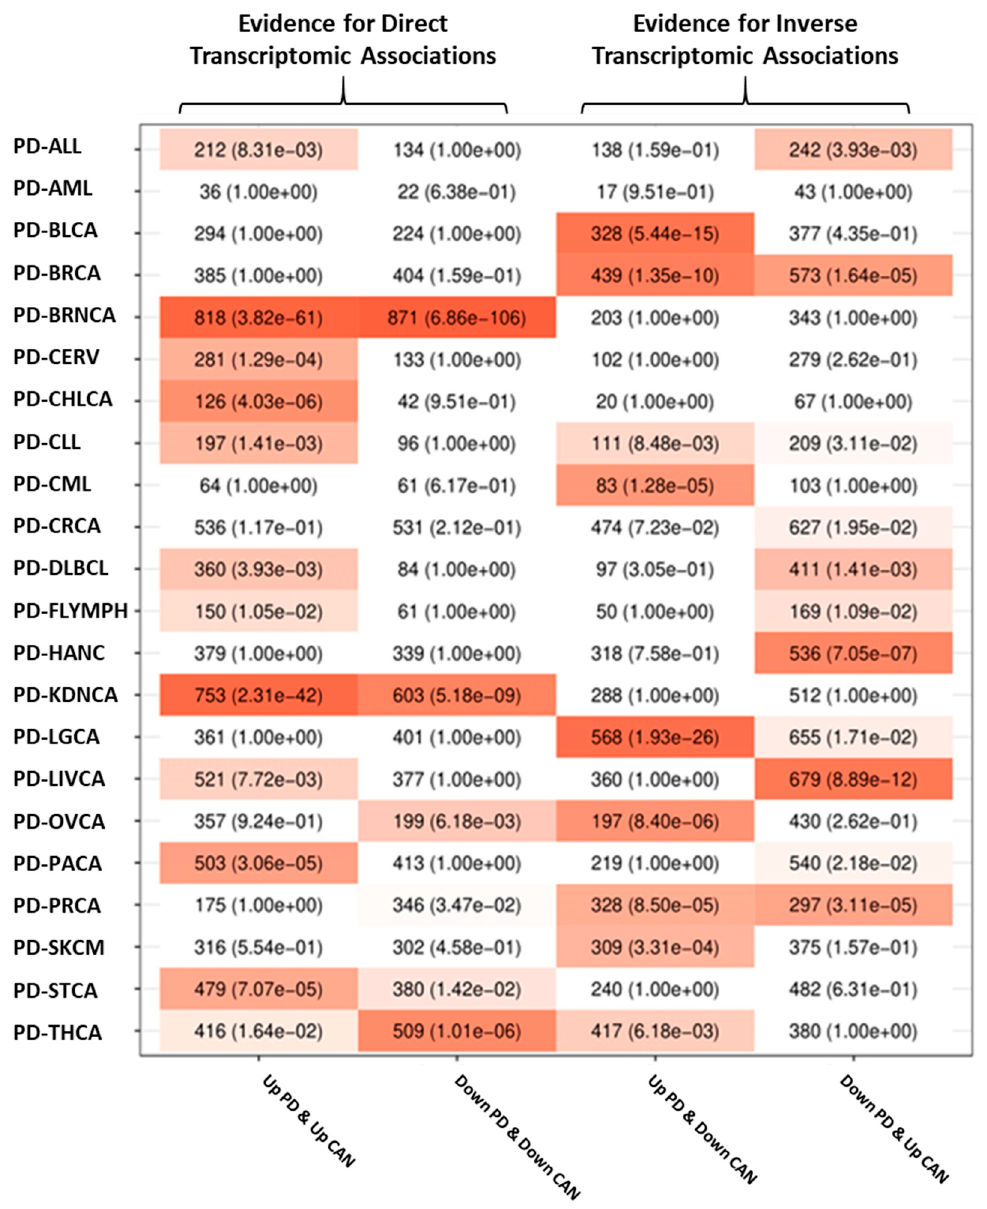
Figure 3. PD and cancer intersection analysis results. Each column shows the number of genes at the four possible intersections formed by up- and downregulated genes in each PD and cancer pair, as well as the FDR-adjusted p -values of Fisher’s exact tests. Column 1 shows genes upregulated in both conditions, column 2 shows genes downregulated in both conditions, column 3 shows genes upregulated in PD and downregulated in each cancer, and column 4 shows genes downregulated in PD and upregulated in each cancer.